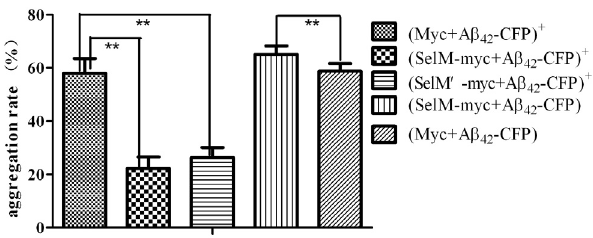
-CFP. HEK293T cells were cotransfected with 42 -CFP 42